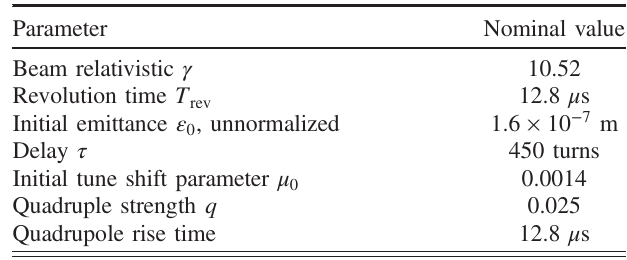
TABLE I. Relevant RHIC parameters for the echo experiments with Au